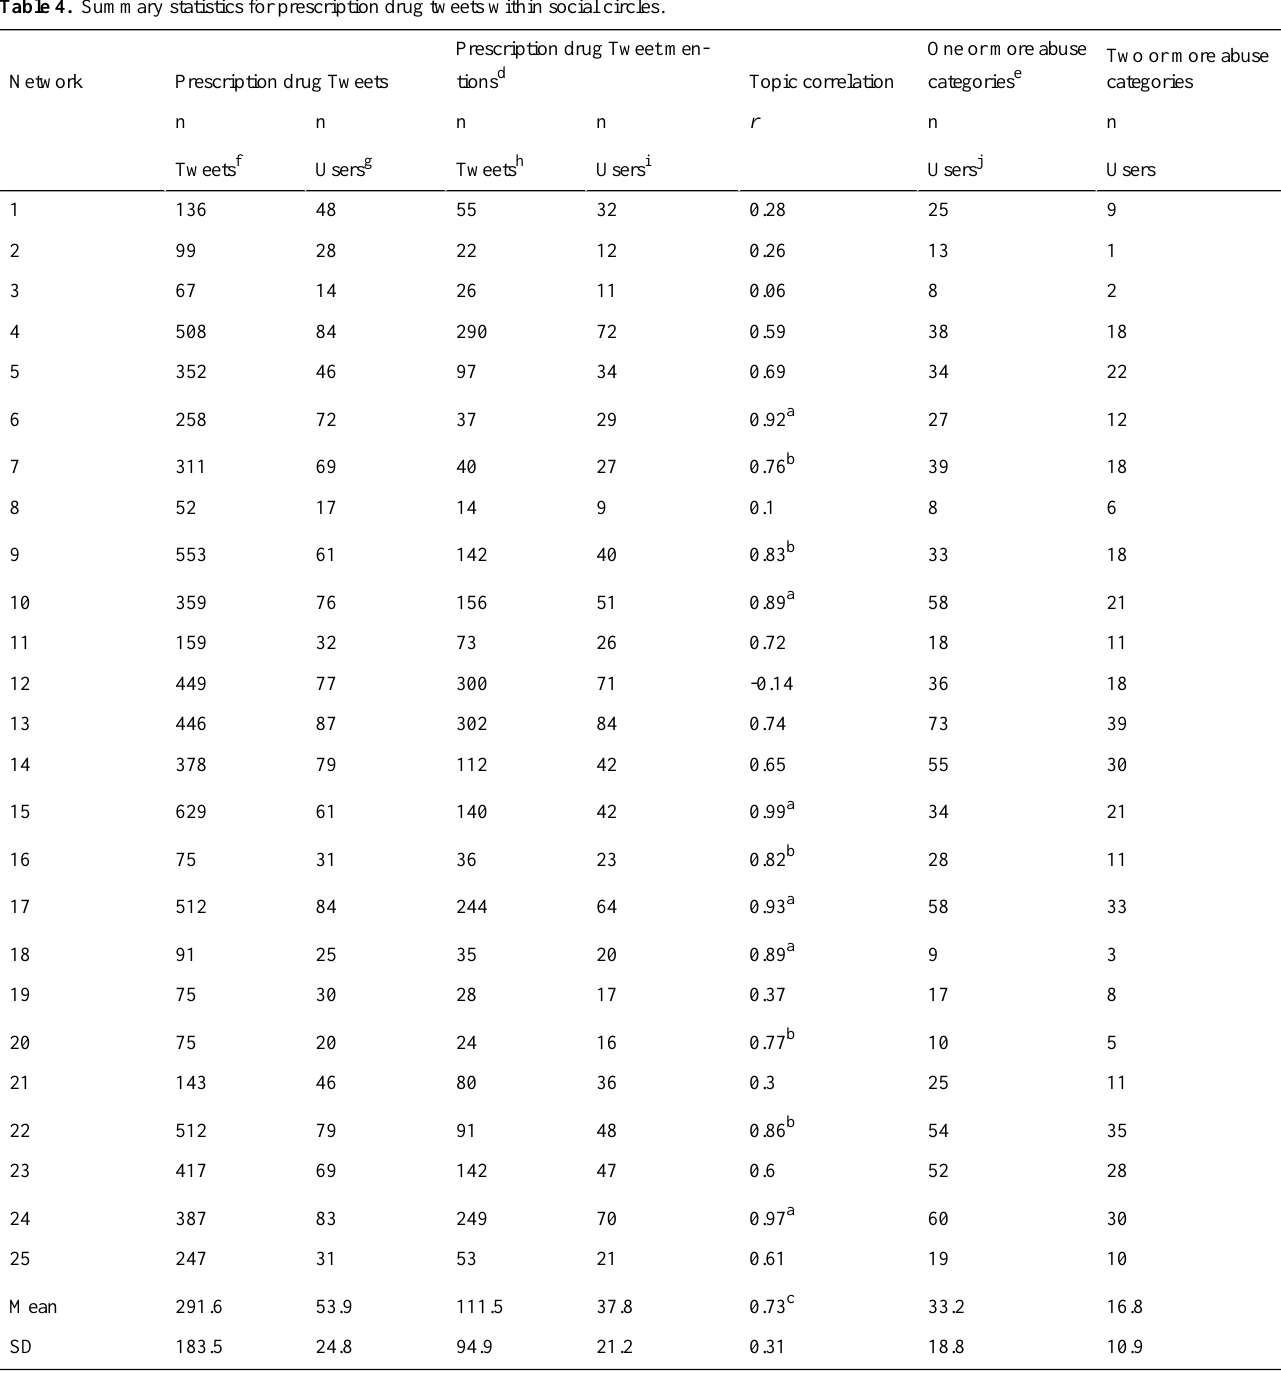
Table 4. Summary statistics for prescription drug tweets within social